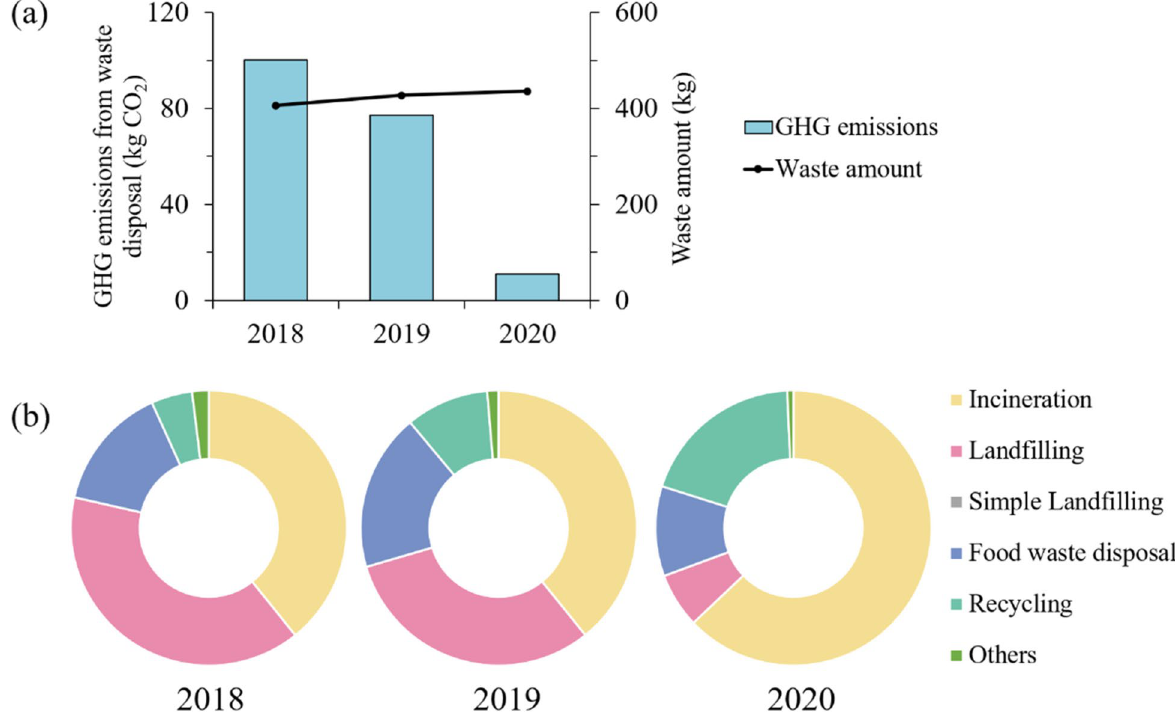
Fig. 5 a The variations of Shanghainese average GHG emissions from waste disposal before and after forced source separation; b The waste disposal structure before and after forced source